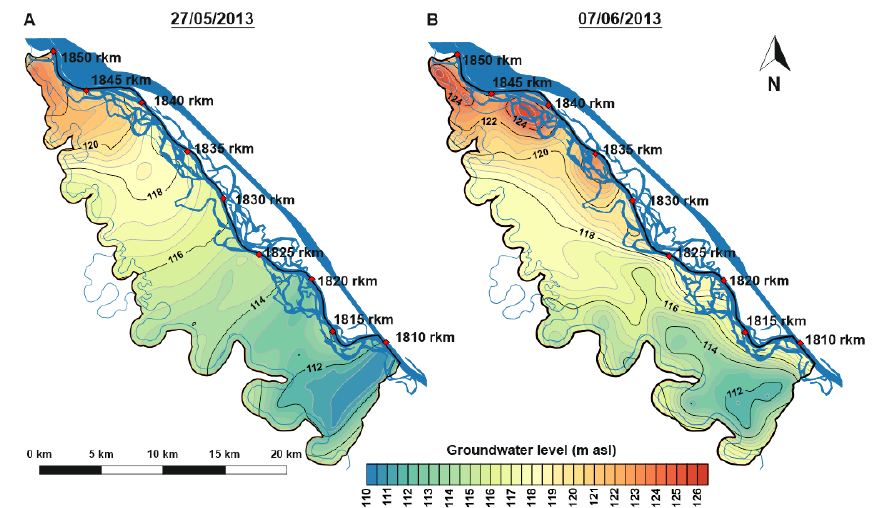
Figure A1. Potentiometric kriged maps of the study area ( A ) prior to and ( B ) during the flood of 2013, taking anisotropy into account [30].